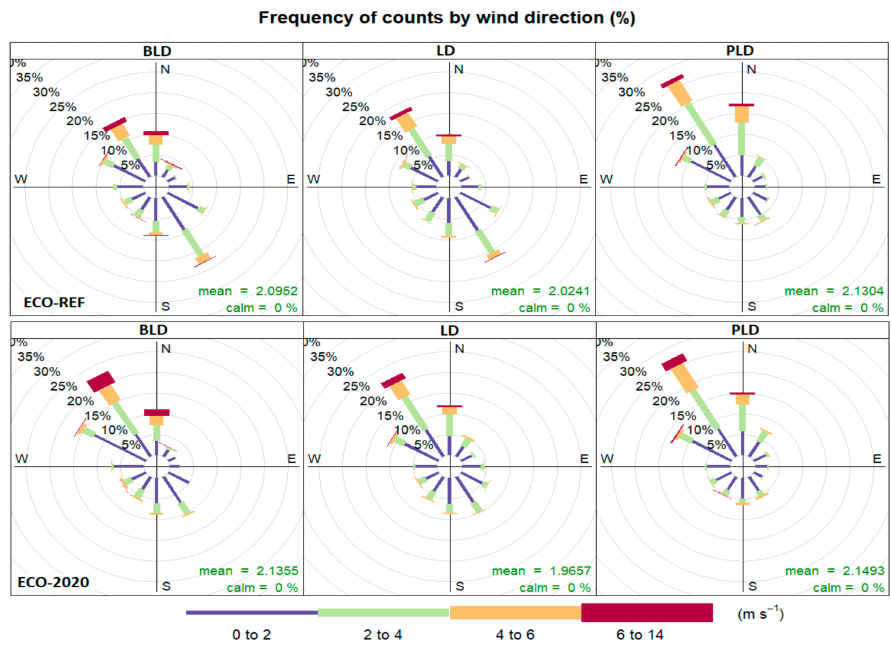
Figure 7. Wind roses related to the three periods (BLD, LD and PLD) of the reference (2015–2019) years and 2020 at the ECO and LMT observatories (from top to down